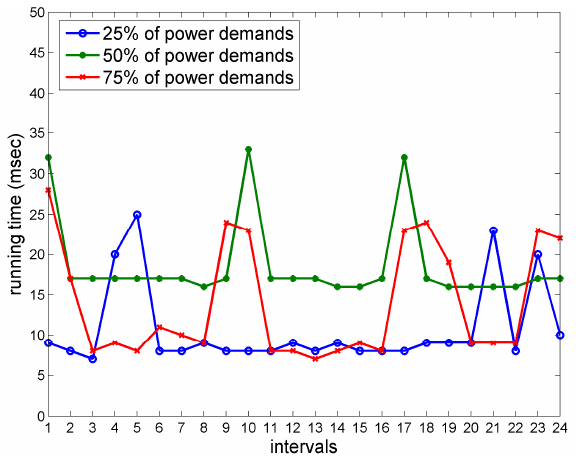
Figure 10. The running time of our load-shedding